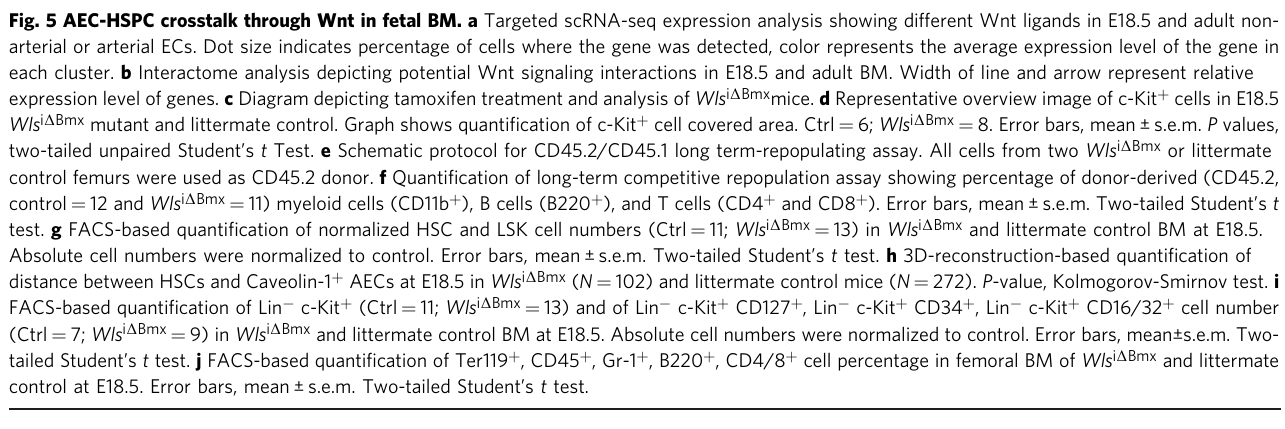
Fig. 5 AEC-HSPC crosstalk through Wnt in fetal BM. a Targeted scRNA-seq expression analysis showing different Wnt ligands in E18.5 and adult non- arterial or arterial ECs. Dot size indicates percentage of cells where the gene was detected, color represents the average expression level of the gene in each cluster. b Interactome analysis depicting potential Wnt signaling interactions in E18.5 and adult BM. Width of line and arrow represent relative expression level of genes. c Diagram depicting tamoxifen treatment and analysis of Wls i Δ Bmx mice. d Representative overview image of c-Kit + cells in E18.5 Wls i Δ Bmx mutant and littermate control. Graph shows quanti fi cation of c-Kit + cell covered area. Ctrl = 6; Wls i Δ Bmx = 8. Error bars, mean ± s.e.m. P values, two-tailed unpaired Student ’ s t Test. e Schematic protocol for CD45.2/CD45.1 long term-repopulating assay. All cells from two Wls i Δ Bmx or littermate control femurs were used as CD45.2 donor. f Quanti fi cation of long-term competitive repopulation assay showing percentage of donor-derived